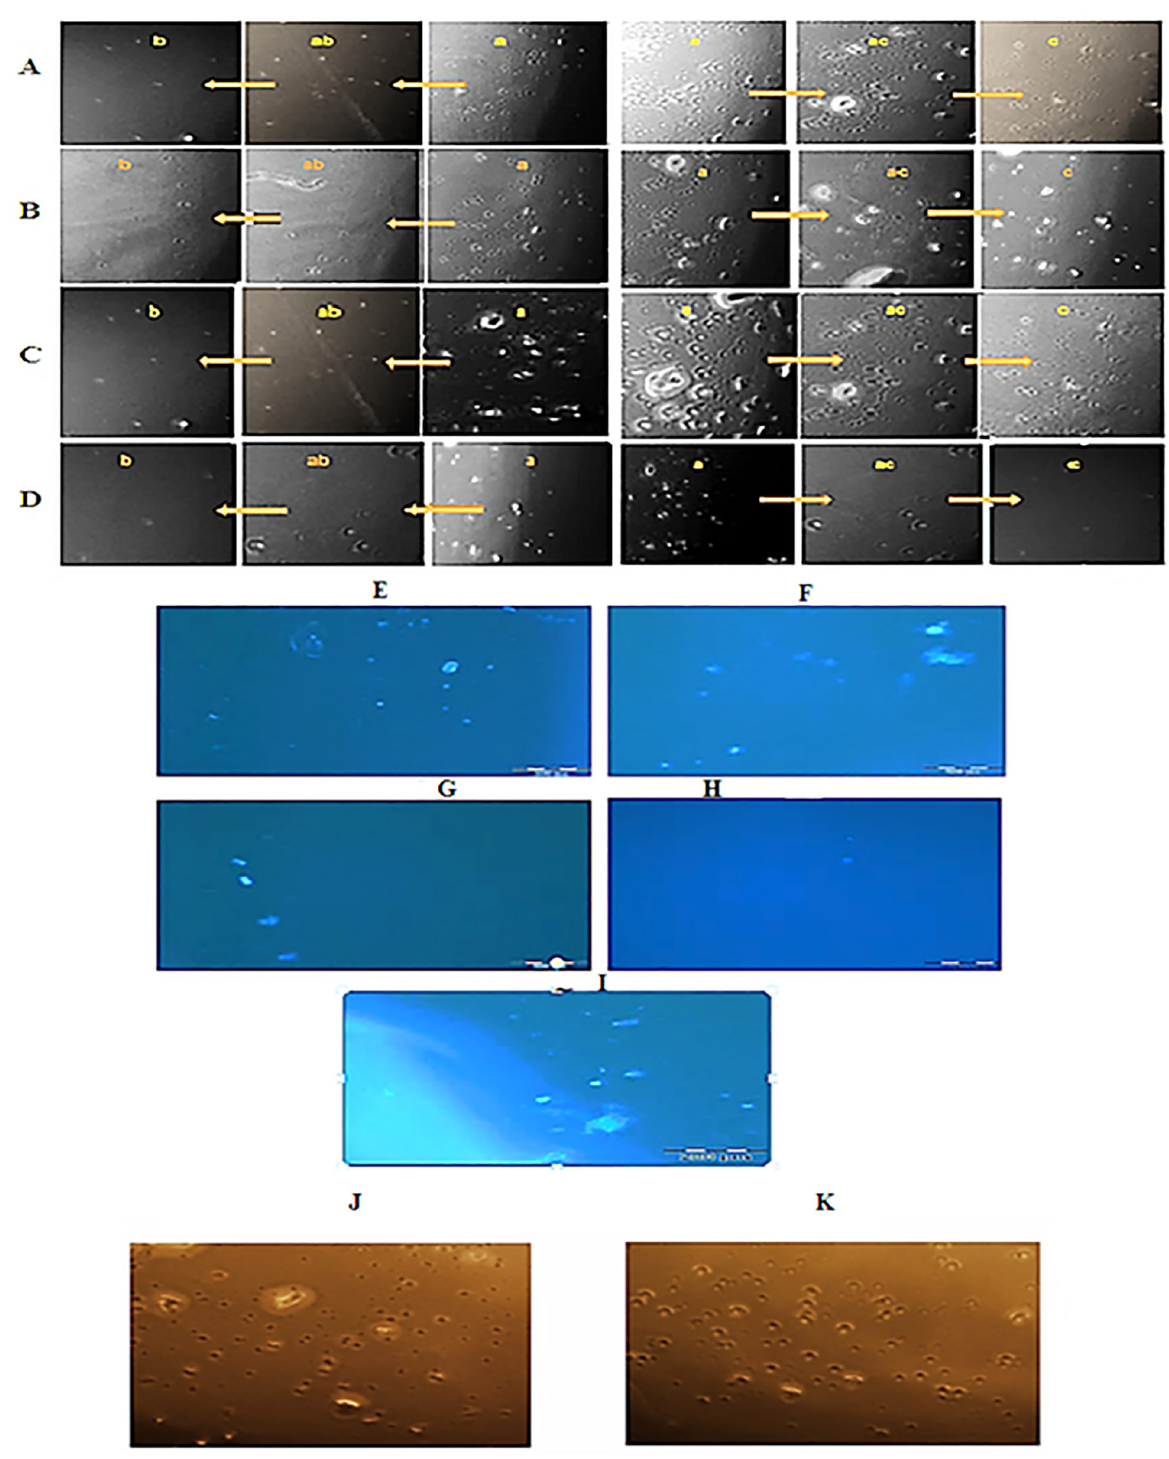
Fig 8. Cells (cells were seeded in the central well; ab: distance between the well containing cells and the well containing negative control (FBS-free DMEM); ac: distance between the well containing cells and the well containing chemoattractants such as CCL21 or FBS as positive control; c: well containing negative control (FBS-free DMEM); b: well containing chemoattractant (such as CCL21 or FBS) as positive control. A) Composite image of cells migrating from cell-containing well to the commercial CCL21 well (right) and the DMEM well (left). B) Composite image of cells migrating from cell-containing well to the purified CCL21 well (right) and the non-recombinant protein well (left). C) Composite image of cells